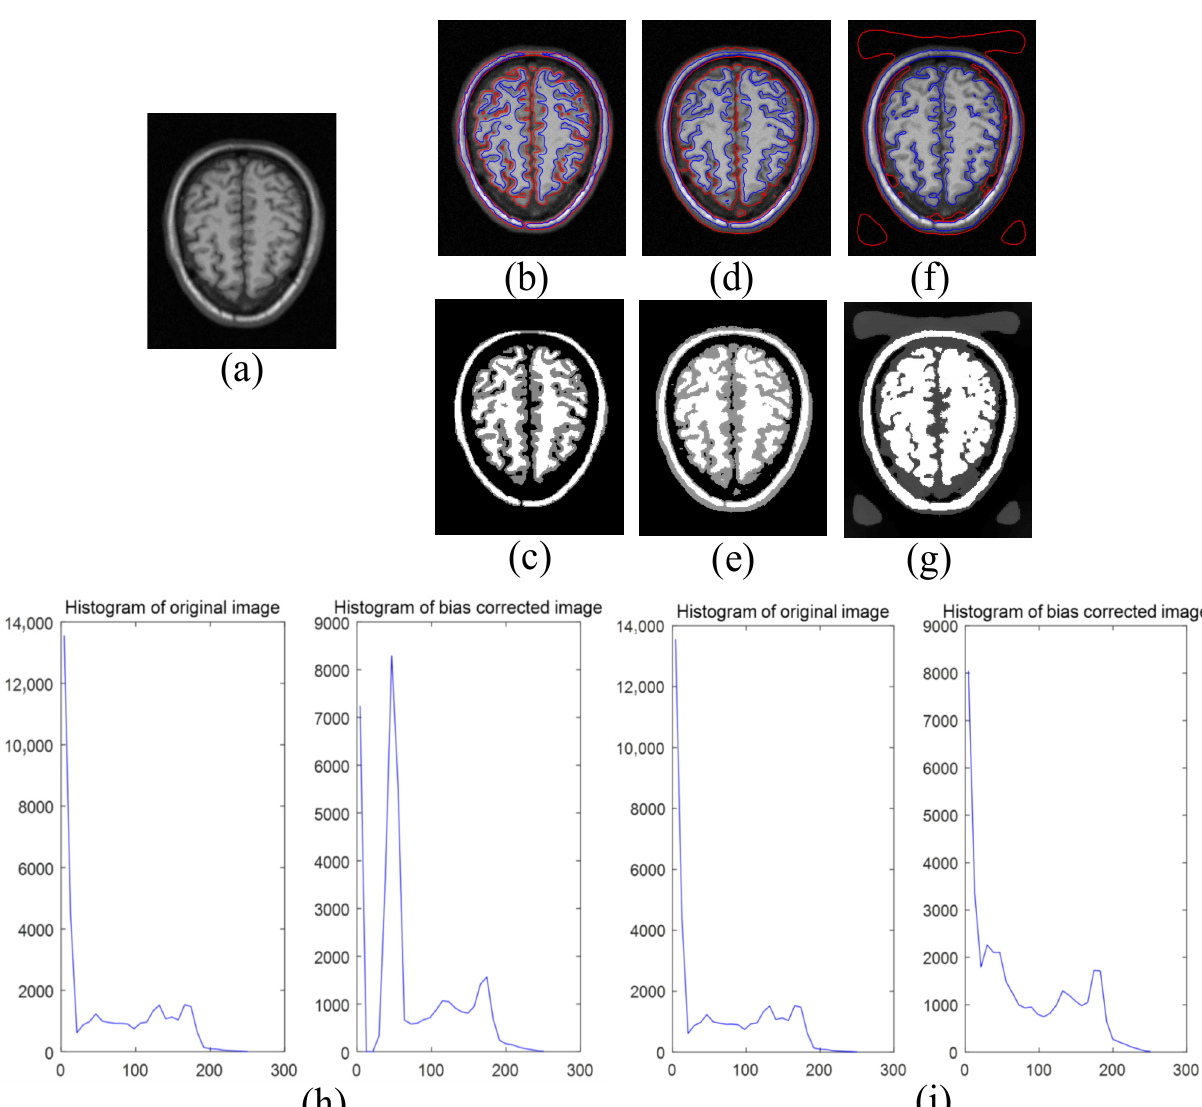
Figure 10. Performance of multiphase level set function and compared with the LIC model and the ALFB model. ( a ) Original image; ( b ) the results of our model; ( c ) the ground truth of our model; ( d ) the result of LIC model; ( e ) the ground truth of LIC model; ( f ) the result of ALFB model; ( g ) the ground truth of ALFB model; ( h ) the histogram of the original image and our model; and ( i ) the histogram of the original image and LIC model.